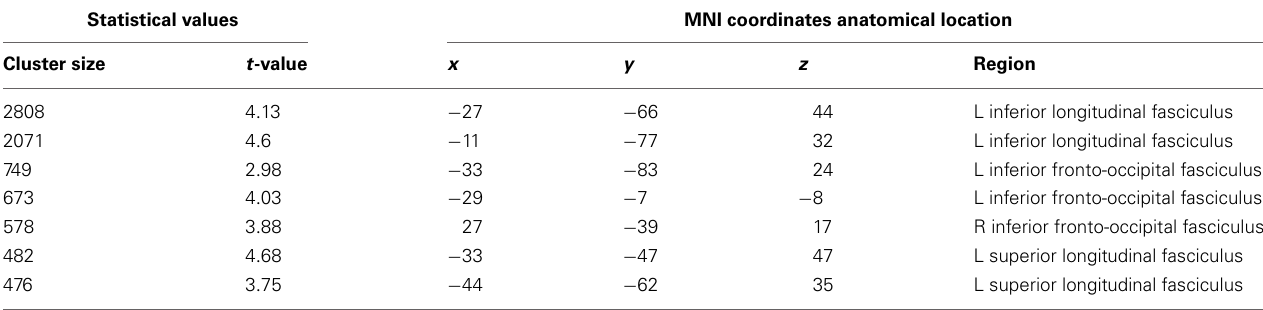
Table 1 | Location and MNI coordinates were given for the clusters with significant correlation between fractional anisotropy and WISC-RC math scores. Statistical values MNI coordinates anatomical location